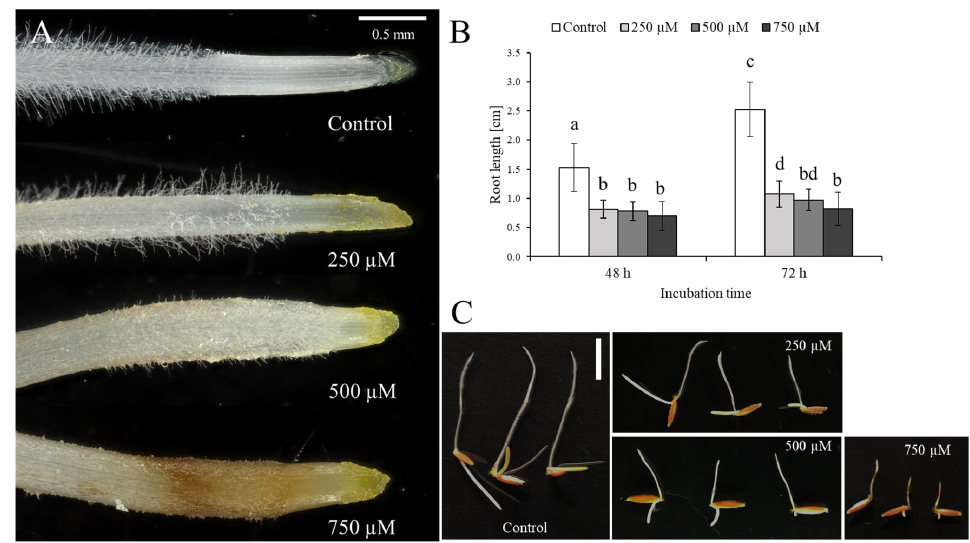
Figure 1. ( A ) Microscopic analysis of the B. distachyon root response after treatment with different (250 µ M, 500 µ M, and 750 µ M) concentrations of 3,4-DHP. ( B ) Changes in the root length after 48 h and 72 h of treatment with 250 µ M, 500 µ M, and 750 µ M 3,4-DHP. Error bars indicate the standard deviation (one-way ANOVA followed by Tukey HSD test, p < 0.05; mean ± SD, statistically significant differences are indicated by different letters). ( C ) Total root length in the control and after 72 h treatment with 250 µ M, 500 µ M, and 750 µ M 3,4-DHP. Scale bar: 1 cm.